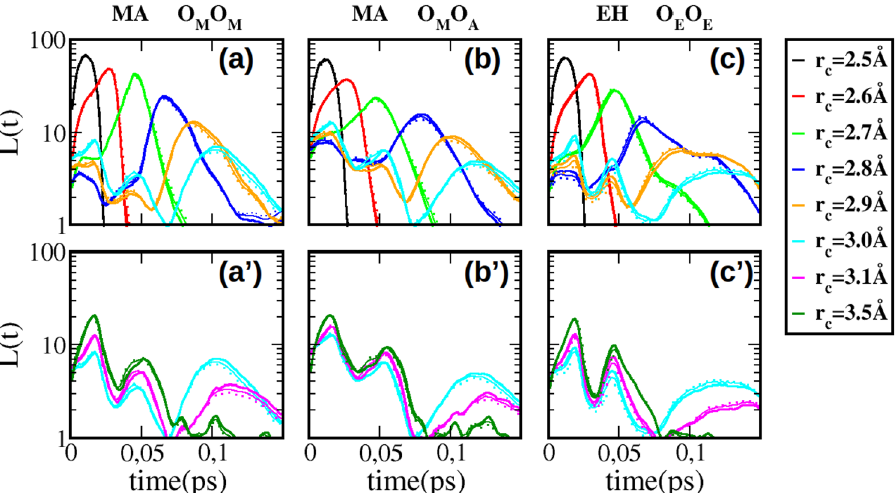
Figure 6. H-bond life time distributions L ( t ) for methanol–acetone (MA) and ethanol–hexane (EH) mixtures. Panel ( a , a’ ) methanol–methanol clusters, ( b , b’ ) for methanol–acetone clusters, and ( c , c’ ) for ethanol–hexane clusters. The upper panels ( a – c ) show the primary peak features, while the lower panels ( a’ – c’ ) show the secondary and tertiary peak features. The thick full lines are for x = 0.2 , the thin lines for x = 0.5 , the dotted lines for x = 0.8 , where x is the alcohol content in the